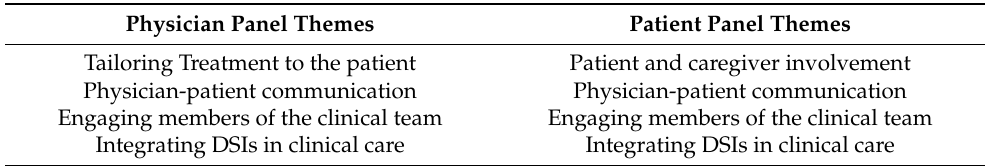
Table 1. Themes identified in interviews with physician and patient panel